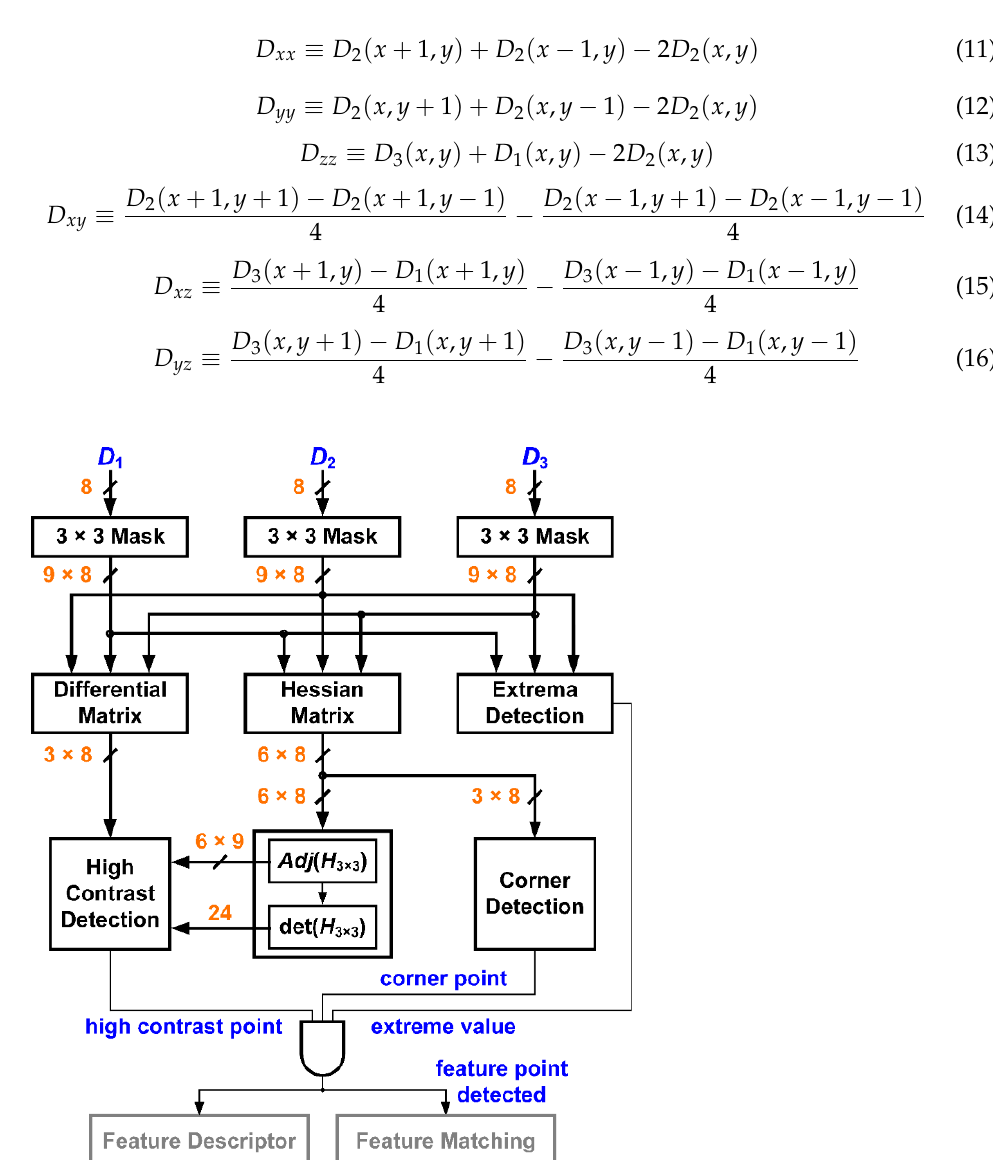
Figure 11. Building blocks of the feature detection.